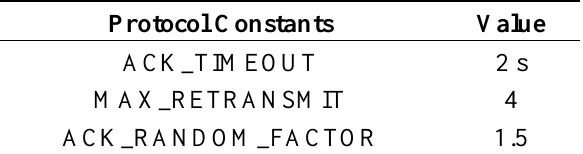
Table 1. CoAP protocol constants for message